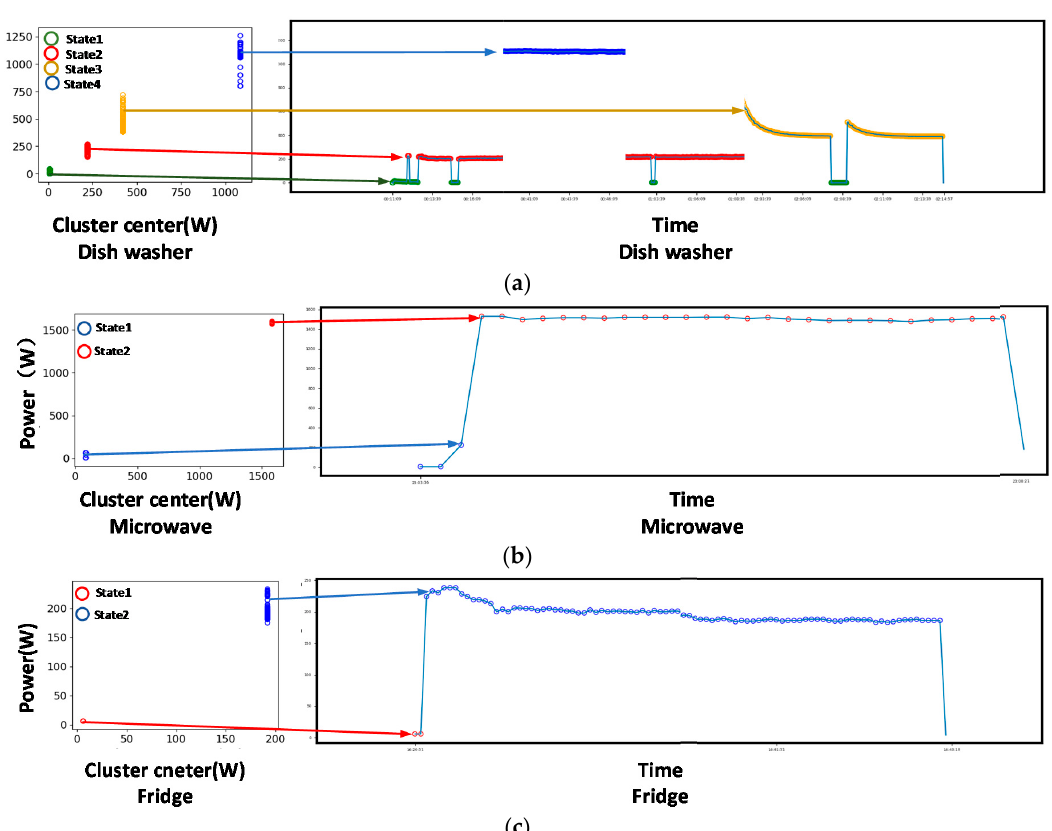
Figure 5. ( a ) Dishwasher status switching diagram. ( b ) Microwave status switching diagram. ( c ) Refrigerator status switching diagram.